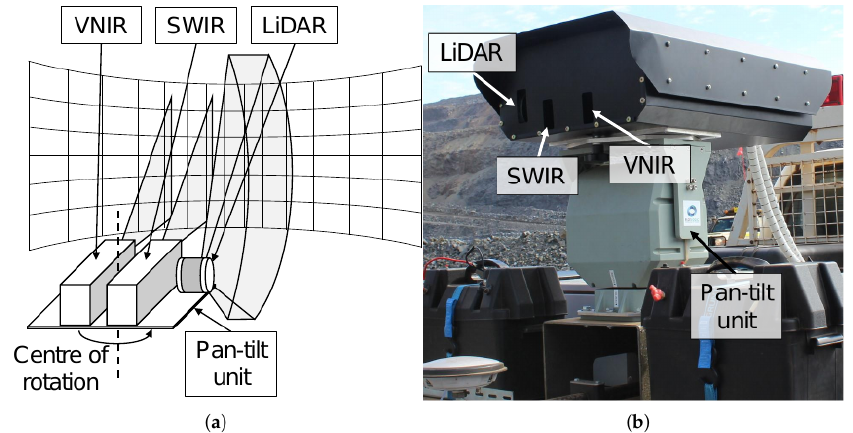
Figure 1. ( a ) Schematic of sensing apparatus showing visible-near-infrared (VNIR) and short- wavelength infrared (SWIR) hyperspectral cameras, LiDAR, and pan-tilt unit. ( b ) Sensing apparatus mounted on a utility vehicle. The hyperspectral cameras and LiDAR are protected by a sun-shading enclosure, shown sitting atop the pan-tilt